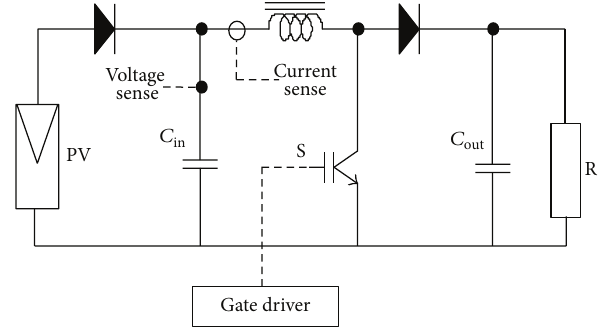
Figure 4: PV panel and power